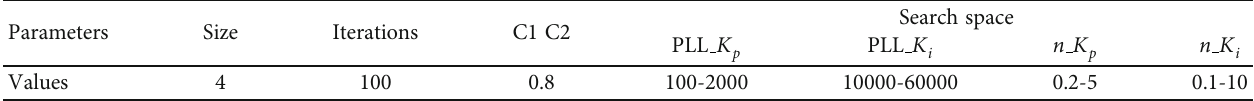
Table 2: Parameters of PSO.